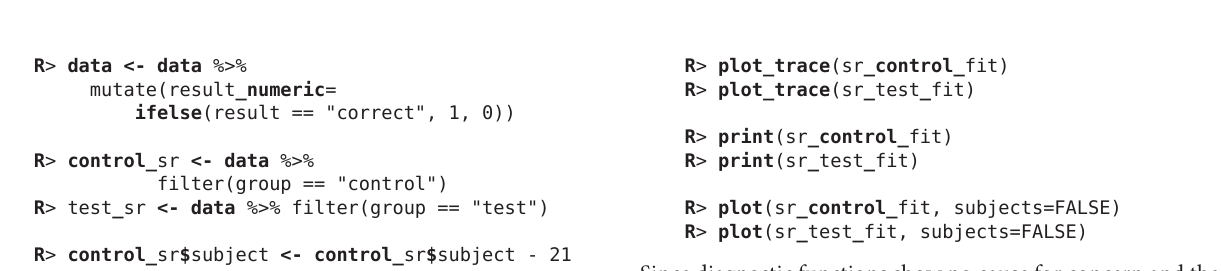
FIGURE 9 | The visualization of means for rt_control_fit and rt_test_fit . Group 1 visualizes means for the healthy subjects and group 2 for the unhealthy